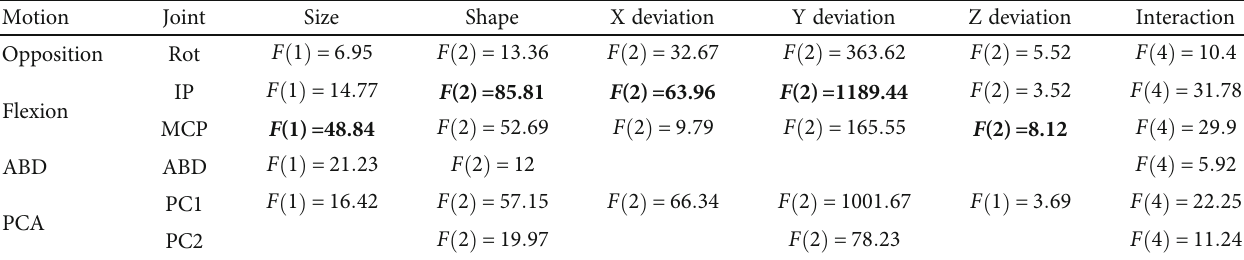
Table 4: F values of the ANOVA on the factor scores of each joint angle and PC of thumb posture.